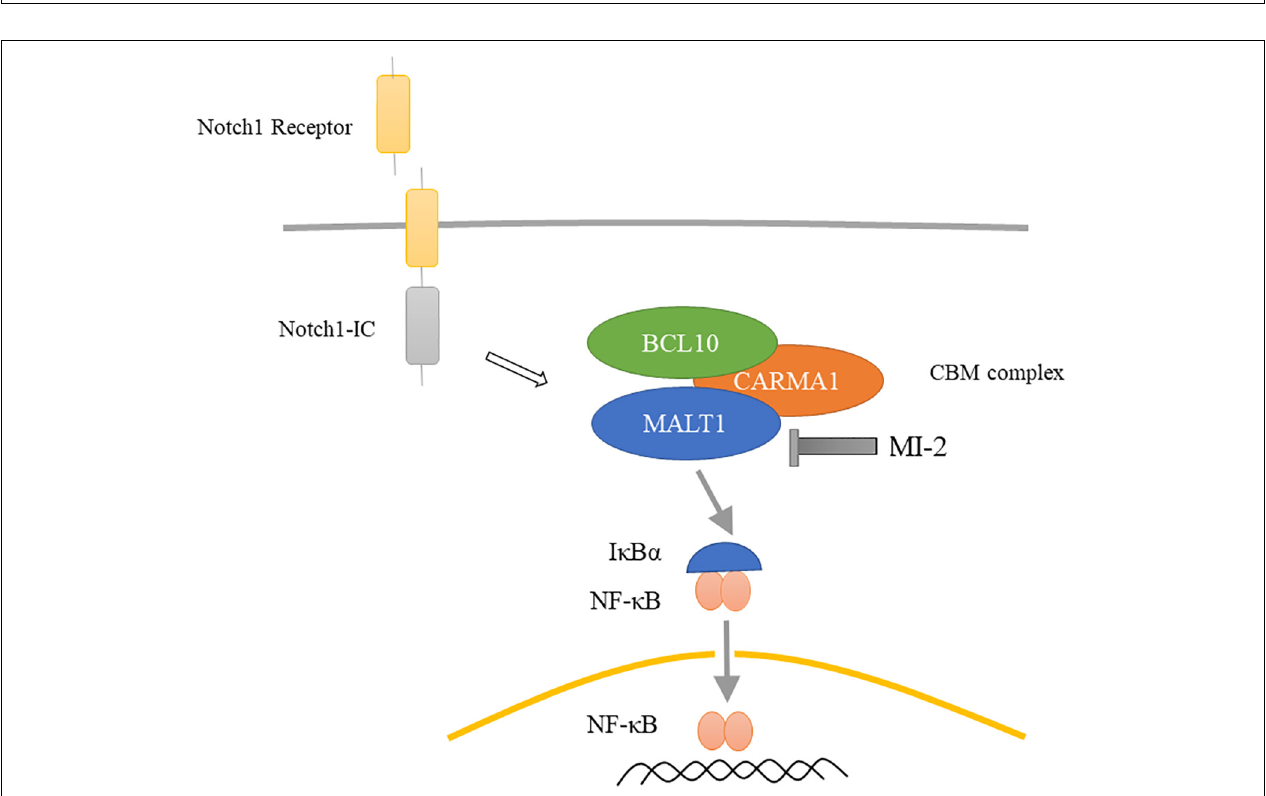
FIGURE 7 | Proposed mechanism for MALT1 inhibition by MI-2. MALT1 is crucial for Notch1-induced NF- κ B activation. MI-2 inhibits NF- κ B activation by increasing I κ B α proteins and inhibiting p65 nucleus translocation.